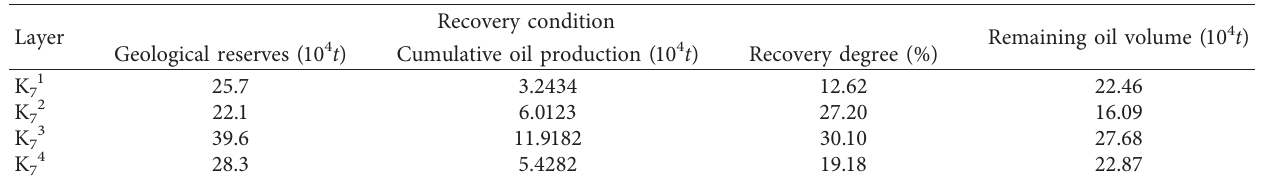
Table 3: Statistics of crude oil recovery (at present).